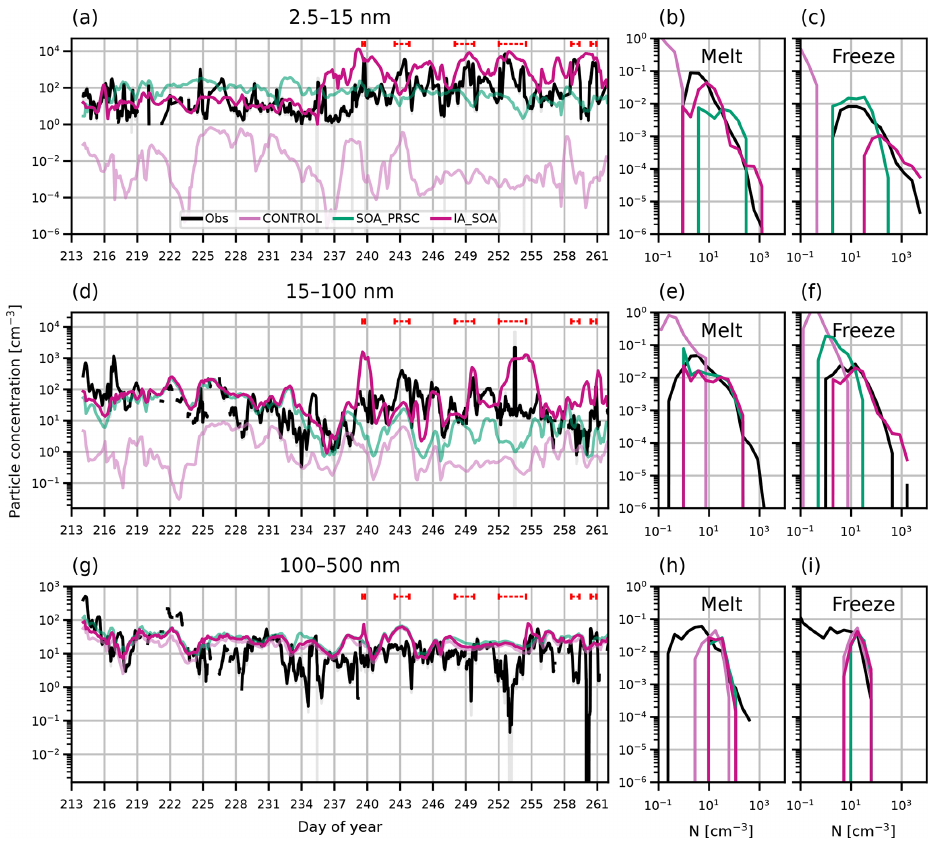
Figure 7. Time series and PDFs of aerosol concentration at the surface during AO2018 from observations and model output. Model output is from simulations CONTROL (pink lines), SOA_PRSC (green lines), and IA_SOA (red lines). Other than IA_SOA and the observations, lines have been made slightly transparent on this figure so that it is easier to view the results from IA_SOA. Observations are shown as 3-hourly mean (black lines) and standard deviation (grey shading). Aerosol concentrations are shown for particles with diameter (a–c) 2.5–15nm, (d–f) 15–100nm, and (g–i) 100–500nm. Dashed red lines in (a) , (d) , and (g) show observed NPF events. PDFs are separated by the observed sea ice freeze-up date, 27 August 2018 (day 239).